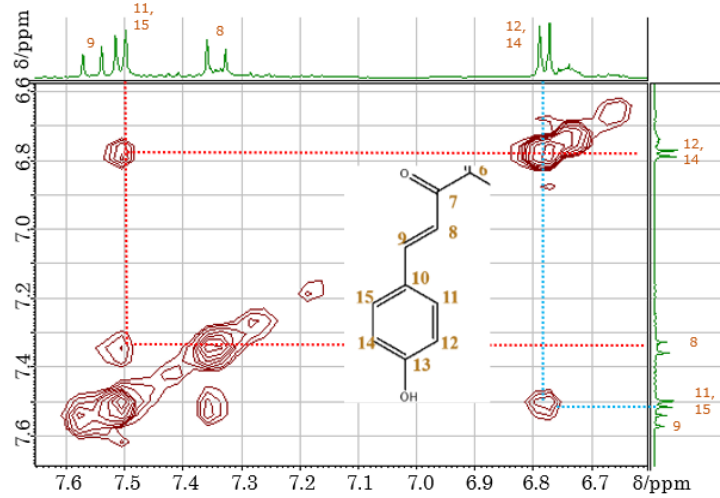
Figure 6. NOESY spectrum of carthamin potassium salt recorded in DMSO- d 6 at 30 ◦ C.